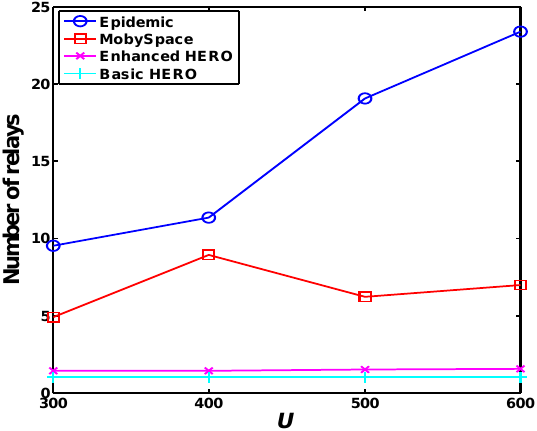
Figure 13. The average number of relays in the four schemes. Owing to the adopted single-copy mechanism, the relay numbers of HERO algorithms are less than those of Epidemic and Mobyspace